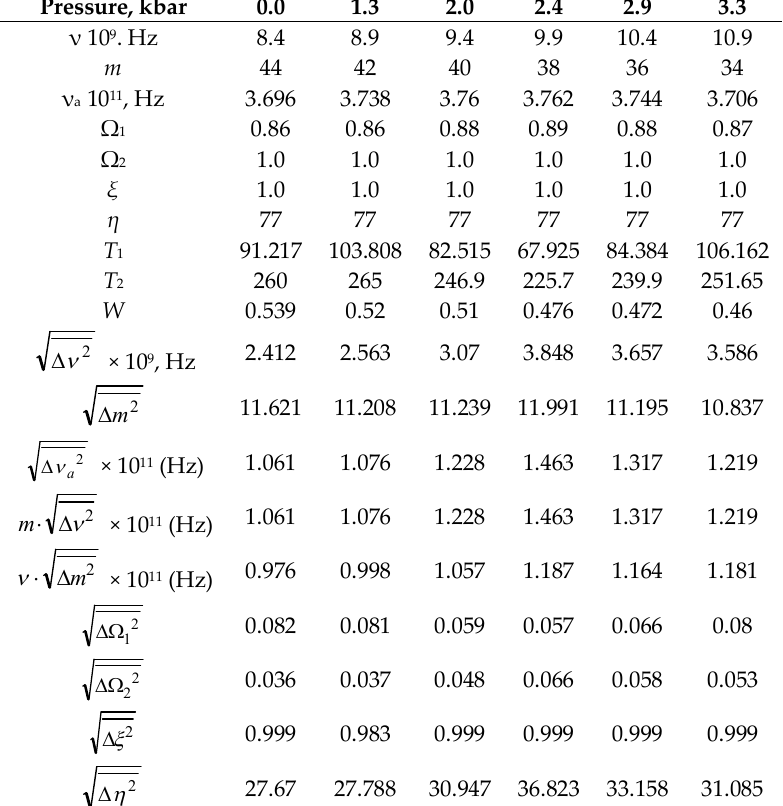
Table 6. Parameters for the double proton transfer in the polycrystalline benzoic acid dimer under various hydrostatic pressures.